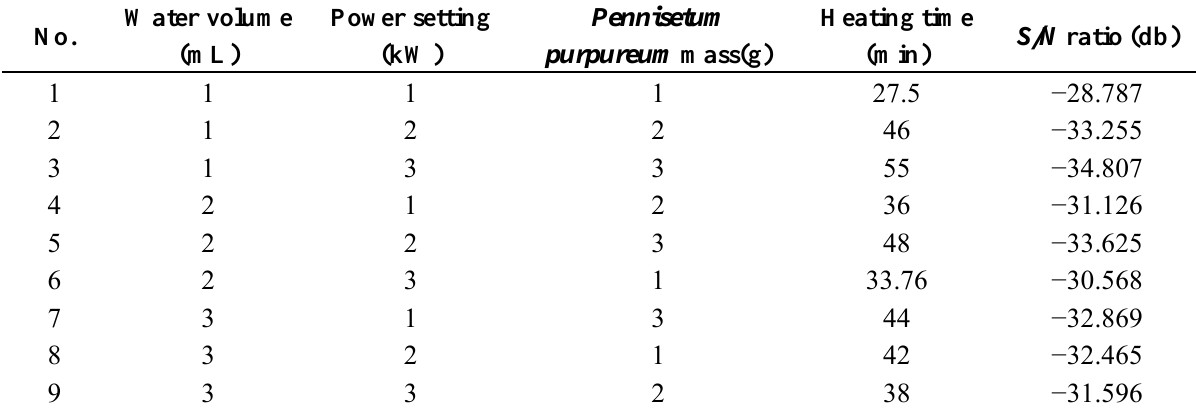
Table 2. L (3 3 ) orthogonal 9